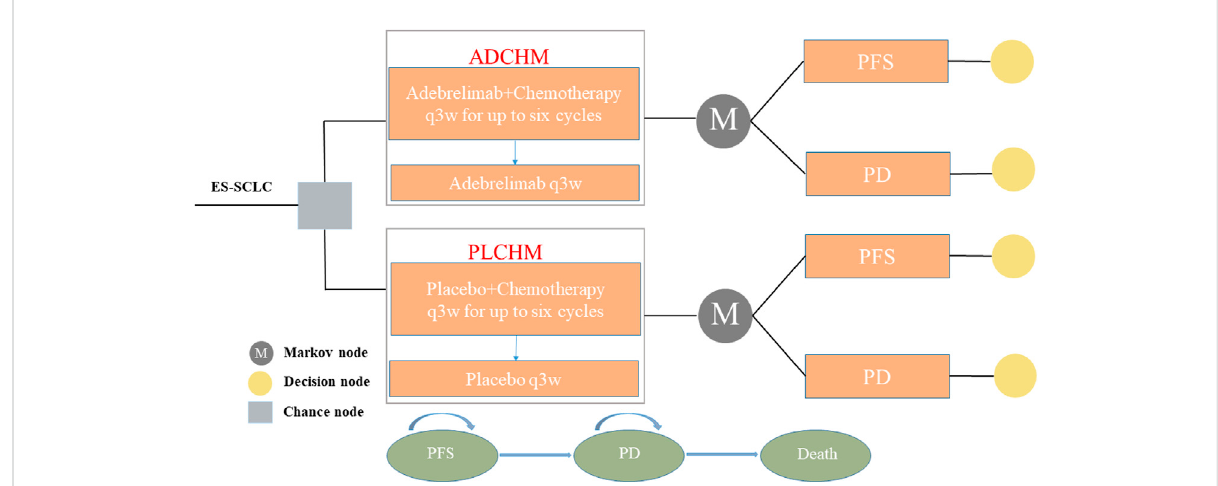
FIGURE 1 TheMarkovmodelsimulatingoutcomesfortheCAPSTONE-1trial.AllpatientswithES-SCLCstartedwithPFSstateandreceivedtreatmentwith ADCHM or PLCHM. ADCHM: adebrelimab in combination with chemotherapy (etoposide-carboplatin); ES-SCLC: extensive-stage small-cell lung cancer. PD: progressive disease; PFS: Progression-free survival; PLCHM: placebo plus chemotherapy